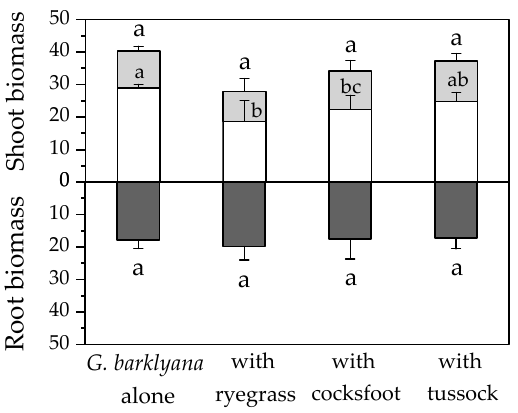
Figure 6. Harvested biomass of Grevillea barklyana (dry wt., g pot − 1 ) when it was grown alone or with one of the three species of grass: Lolium perenne (ryegrass), Dactylis glomerata (cocksfoot), or Poa cita (tussock grass). Shoot biomass shows stems (open bars) and foliage (shaded bars). Different letters indicate significant differences ( p < 0.05) within separate plant components.